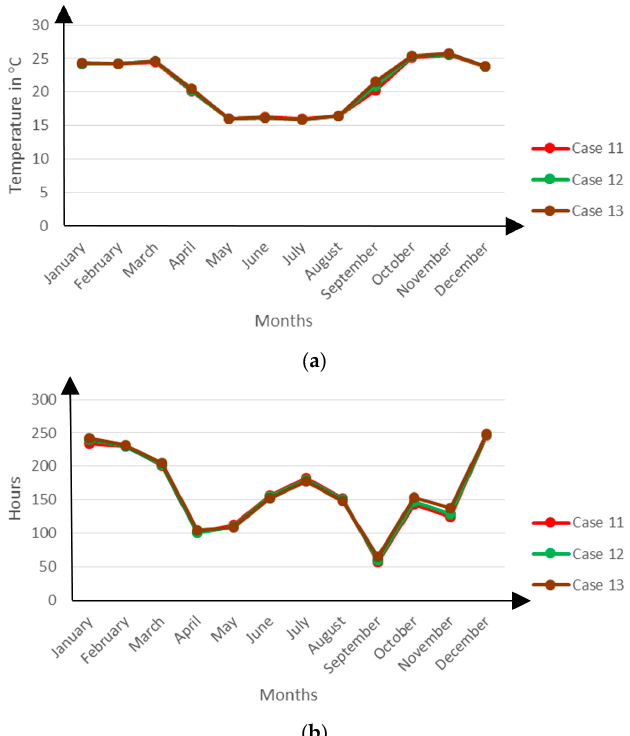
Figure 14. Monthly mean zonal temperatures ( a ) and discomfort hours ( b ) for Cases 11, 12 and 13. However, Case 11 registers slightly lower monthly mean zonal temperatures during the warmer periods and slightly higher discomfort hours during the winter period. This can be attributed to the insulation effect accorded by the triple glazing. This effect is similar to that accorded in the Cases 5, 8 and 10. 4.7. Impact of Varying Infiltration Rates The statistical Analysis of Variance from the first simulation results showed that air infiltration through the air bricks constituted the most significant feature of all the seven features having the most substantial contribution to the buildings thermal performance. During the comprehensive second round of simulation runs planned by the listing method, the air infiltration rates are varied between 0 m 3 ∙ s − 1 , 0.0601 m 3 ∙ s − 1 and 0.1204 m 3 ∙ s − 1 in Cases 14, 15 and 16 respectively. In Case 14, the model’s envelope does not have any air bricks fitted. The infiltration occurs only through the envelope’s cracks and any other such unintended openings. Case 15 has four air bricks positioned above and below all window openings. These air bricks are typically sized being 215 mm × 140 mm. Case 16 also has four air bricks above and below every window opening, but these are much larger than is typically the case being 430 mm × 140 mm. The envelope configuration for these Cases is provided in Figure A5. The simulation results show very distinct differences in the models’ thermal performance. Case 14 registers the highest monthly mean zonal temperatures followed by Case 15, with Case 16 at the very bottom. The Figure 15 below presents the zonal temperature variation: